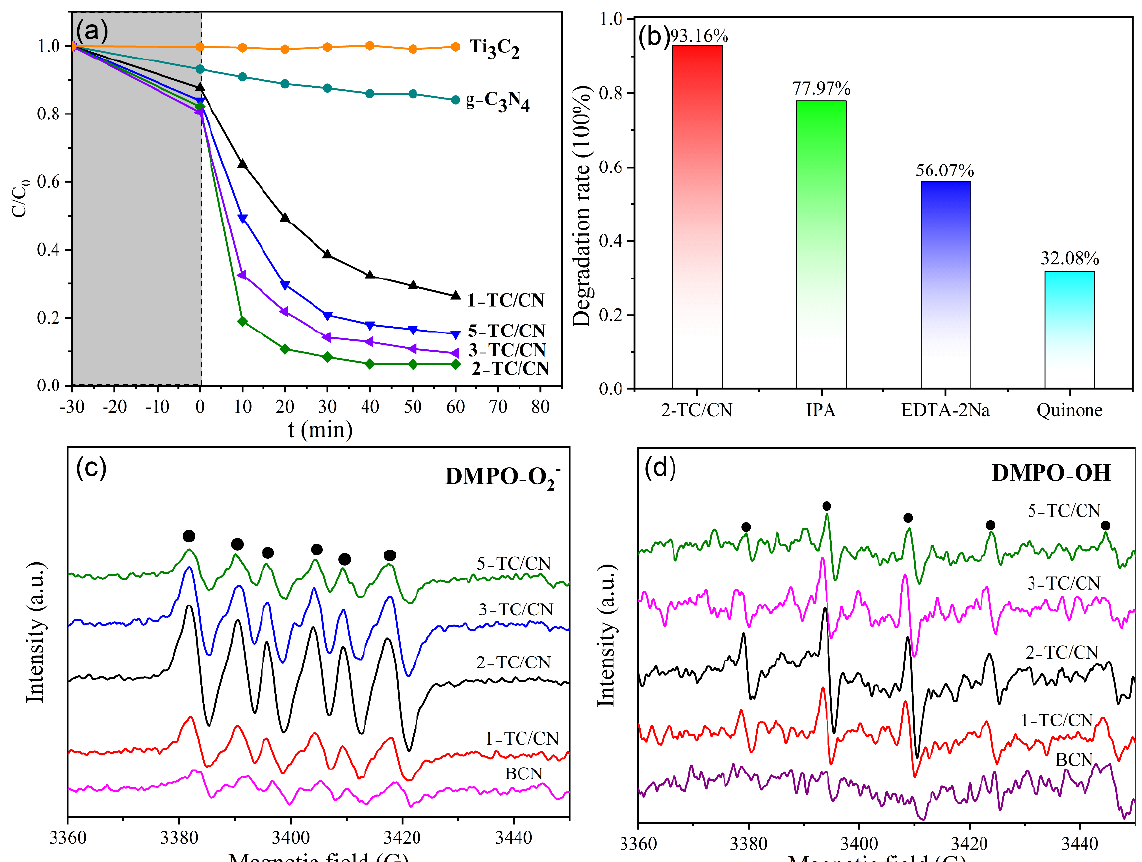
Figure 5. ( a ) Photodegradation of tetracycline by g − C 3 N 4 and 1 − TC/CN, 2 − TC/CN, 3 − TC/CN, 5 − TC/CN, ( b ) the effect of IPA, EDTA − 2Na and quinone on the photodegradation of tetracycline, spin − trapping EPR spectra of g − C 3 N 4 and 1 − TC/CN, 2 − TC/CN, 3 − TC/CN, 5 − TC/CN ( c ) in aqueous dispersion and ( d ) in methanol dispersion after light irradiation, using DMPO as a radical − trapping agent.